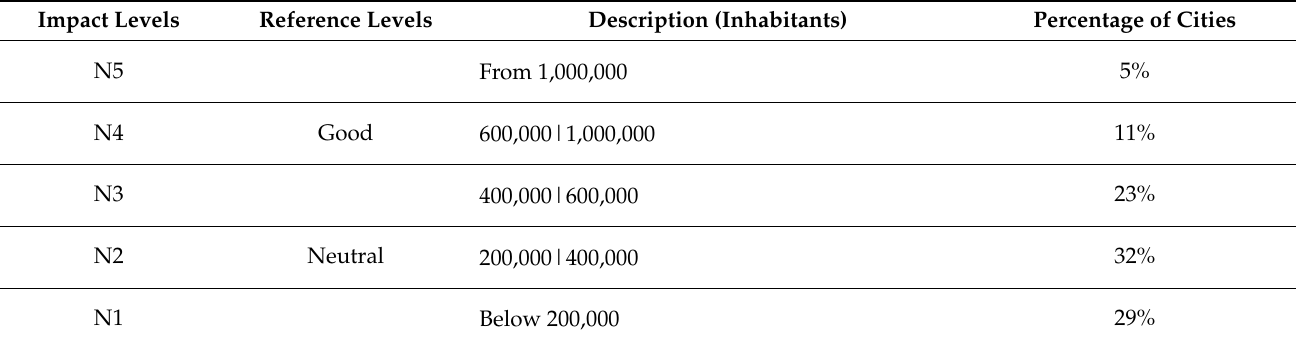
Table 2. Descriptors of FPV 1—population of the immediate region.